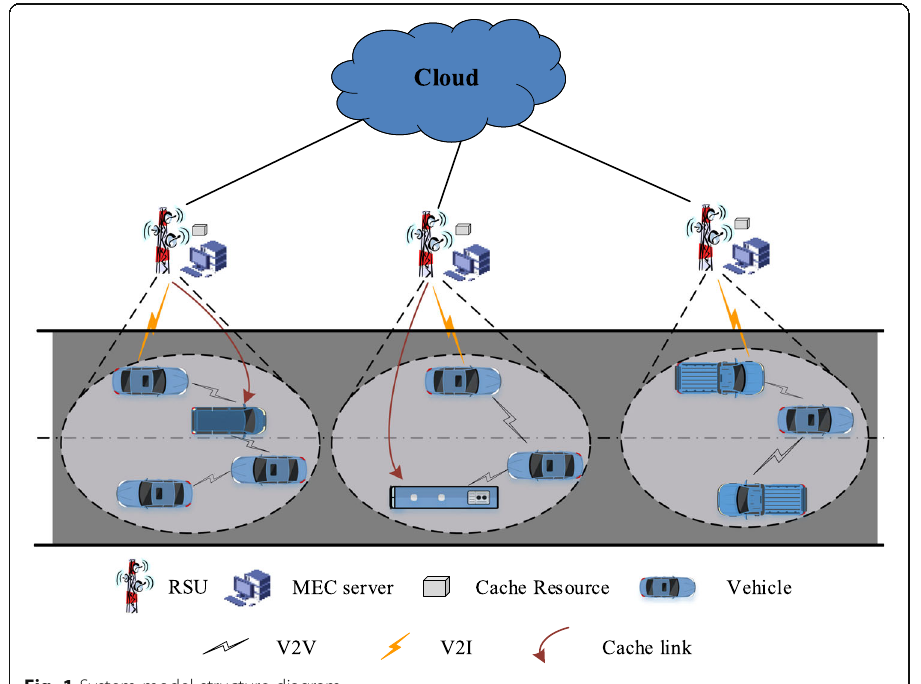
Fig. 1 System model structure